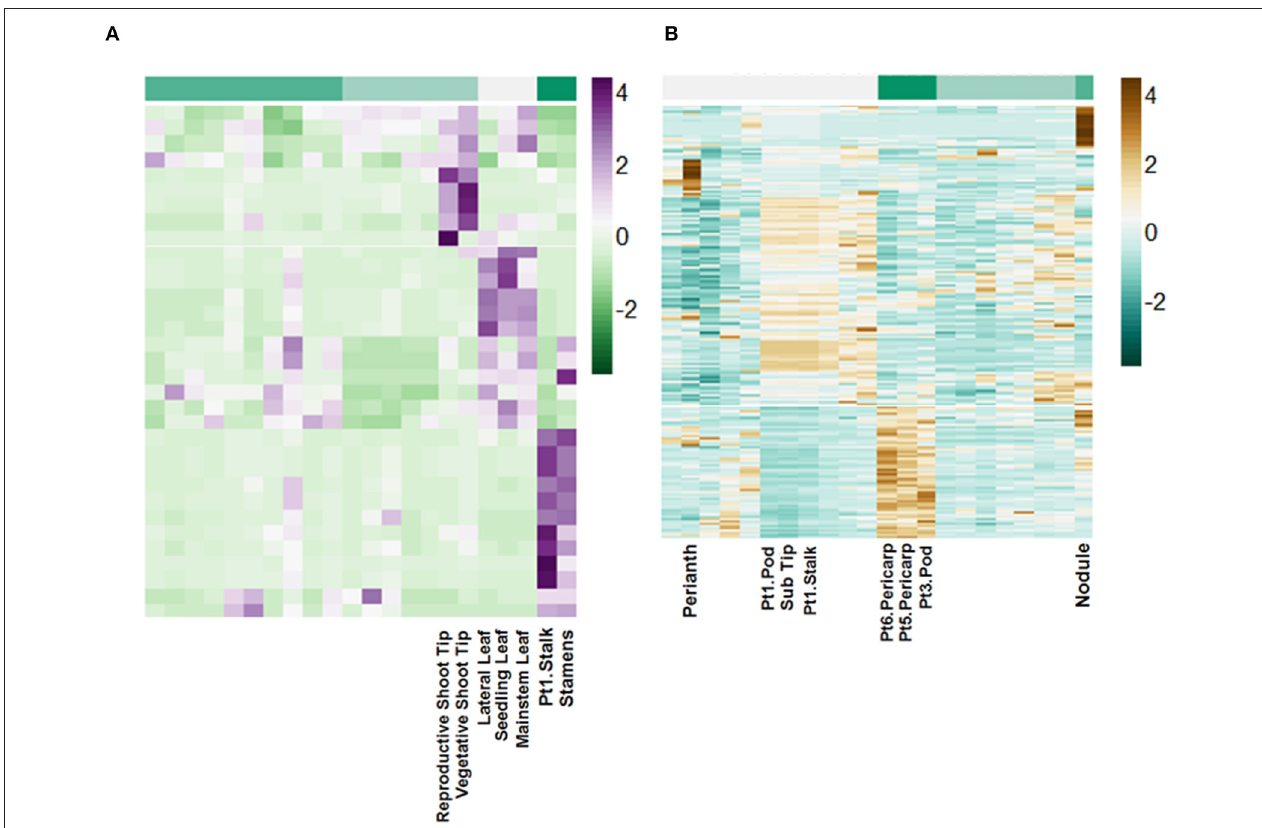
FIGURE 7 | Tissue-specific regulation of putative lncRNAs. Scale is Z-score normalized relative expression. (A) Regulation of selected pri-miRNA transcripts. (B) Regulation of selected intergenic lncRNA